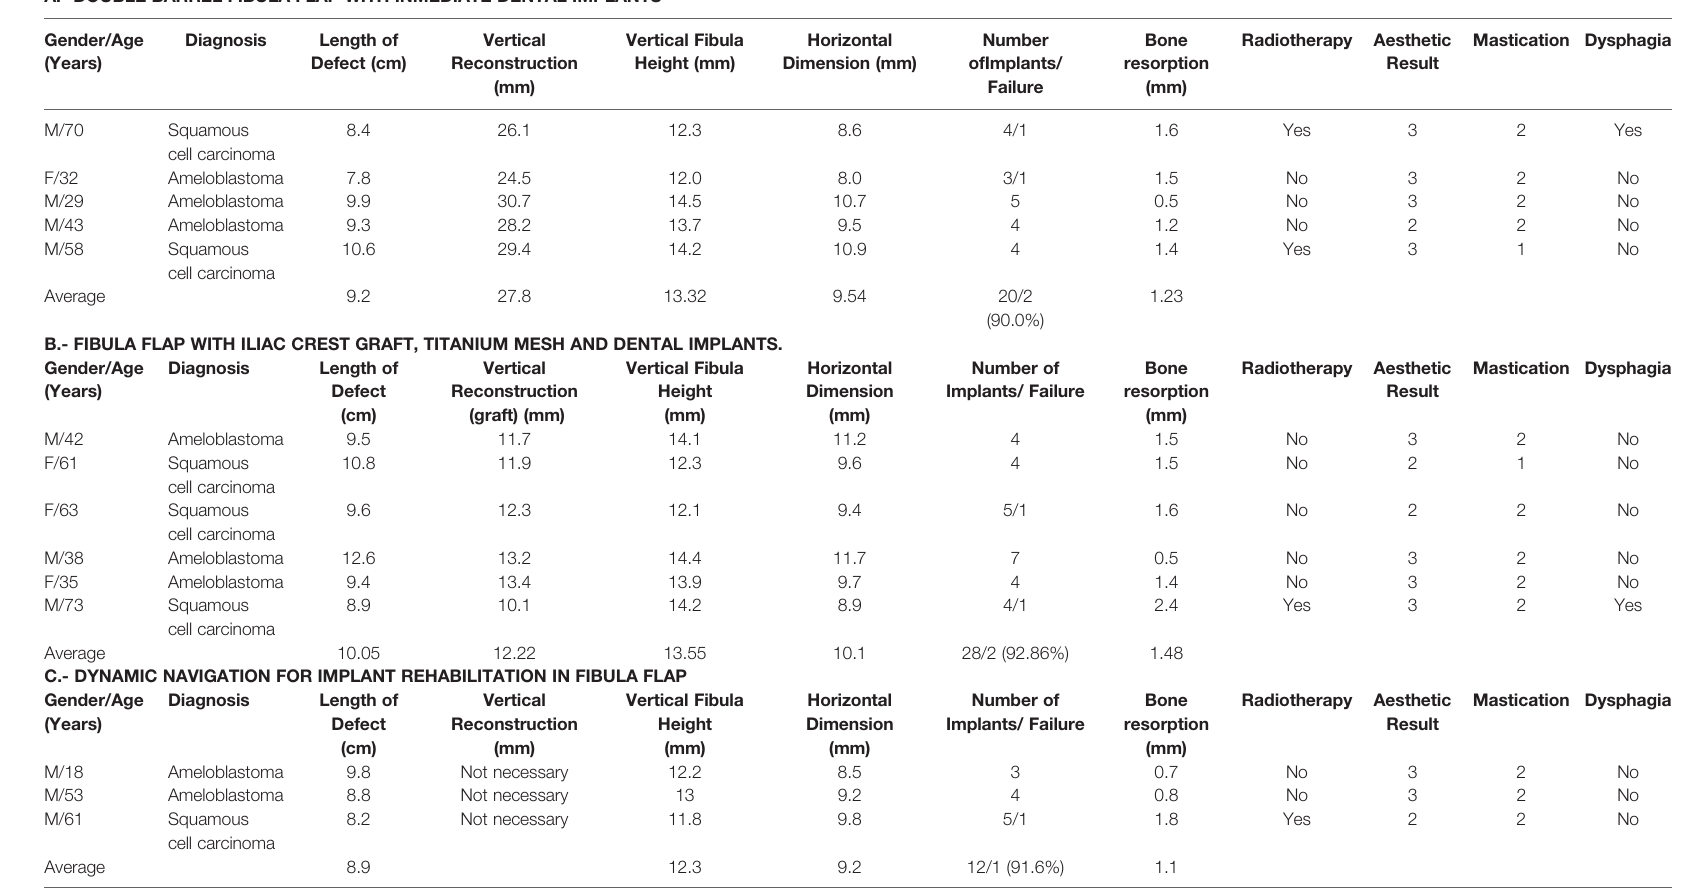
TABLE 1 | Outcomes with three different techniques for mandible reconstruction and implant rehabilitation in oncologic patients. A.- DOUBLE BARREL FIBULA FLAP WITH INMEDIATE DENTAL